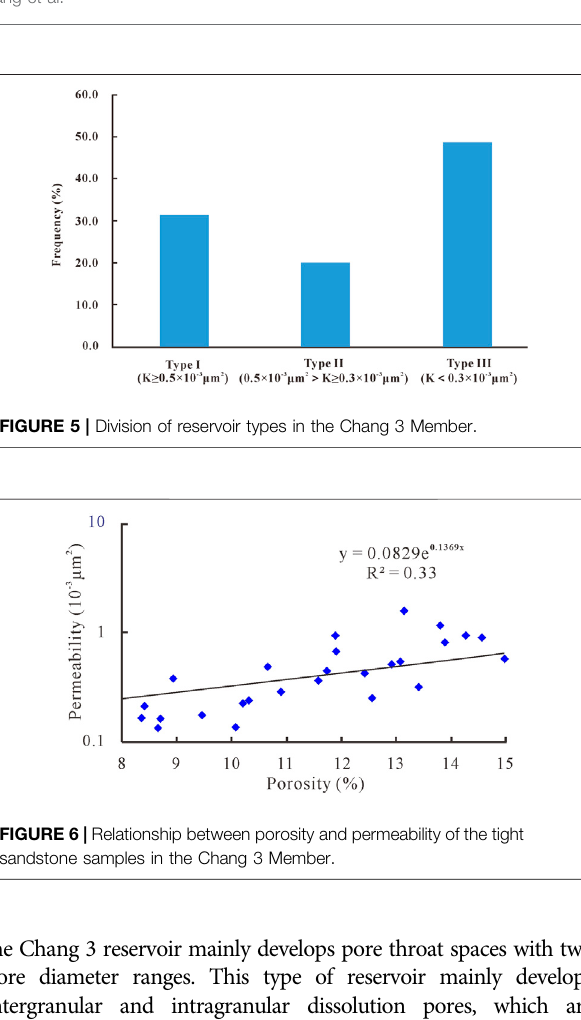
Frontiers in Earth Science |